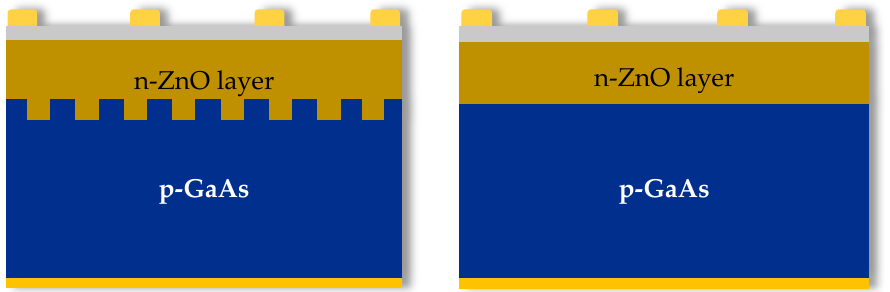
Figure 5. Schematic drawings of the investigated solar cell’s structure with ( left ) and without ( right ) microgrooves at the interfaces.